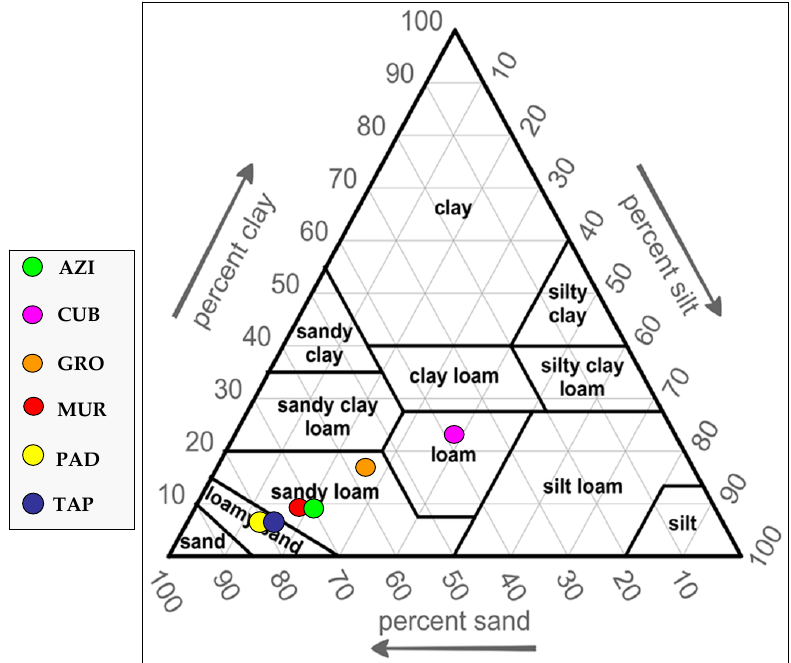
Figure 3. Graphical representation of the soil texture of the six experimental fields used in this study. (United States Department of Agriculture, USDA soil taxonomy).